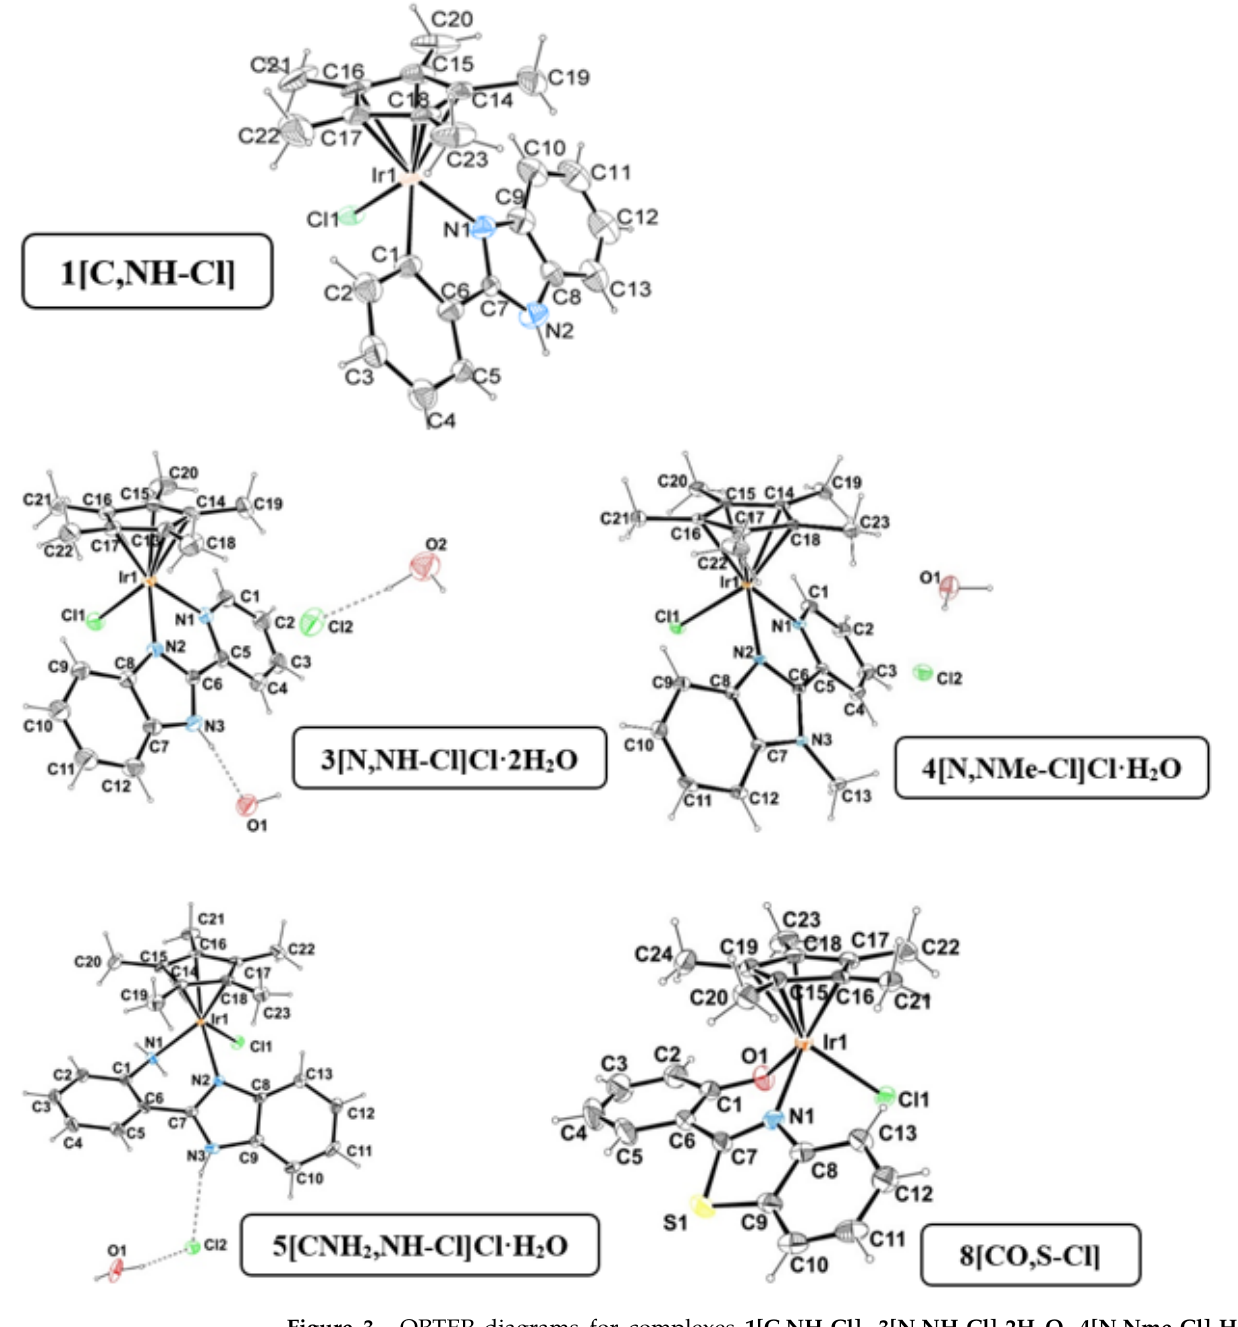
Figure 3. ORTEP diagrams for complexes 1[C,NH-Cl] , 3[N,NH-Cl] · 2H 2 O , 4[N,Nme-Cl] · H 2 O , Figure 2. ORTEP diagrams for complexes 1[C,NH-Cl] , 3[N,NH-Cl]·2H 2 O , 4[N,Nme-Cl]·H 2 O , 5[CNH 2 ,NH-Cl] · H 2 O and 8[CO,S-Cl] . Ellipsoids are shown at 30% 5[CNH 2 ,NH-Cl]·H 2 O and 8[CO,S-Cl] . Ellipsoids are shown at 30% probability. Cell culture. Epithelial ovarian carcinoma cells (A2780) that acquired resistance to cisplatin epithelial ovarian carcinoma cells (A2780cis), colon adenocarcinoma cells (SW480) and epithelial lung adenocarcinoma cells (A549) were provided by Sigma Al- drich. A549 and SW480 cells were grown in Dulbecco′s Modified Eagle′s Medium (DMEM), supplemented with 10% Fetal Bovine Serum (FBS) and 1% penicillin, strepto- mycin and 1% glutamine for A549 and 1% amphotericin B for SW480. The A2780 and